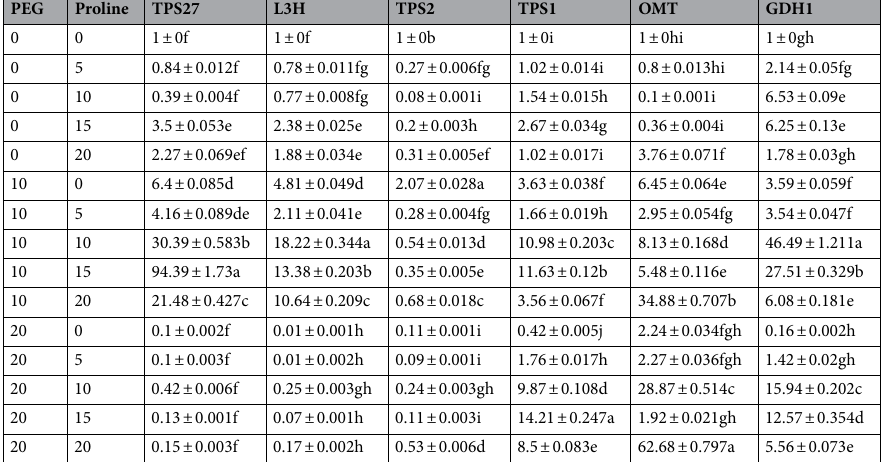
Table 2. Mean comparison of PEG by proline levels for expression rate of the selected genes in surahalala plants. Mean ± Standard error (based on 3 glass containers as replications). In each column, means with the same letter(s) are not significantly different (LSD 5%).